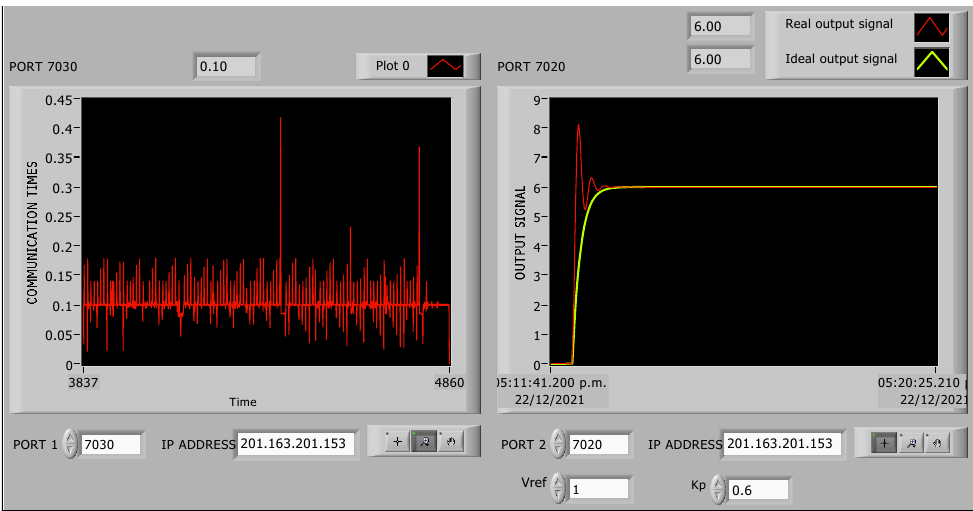
Figure 6. Client B front